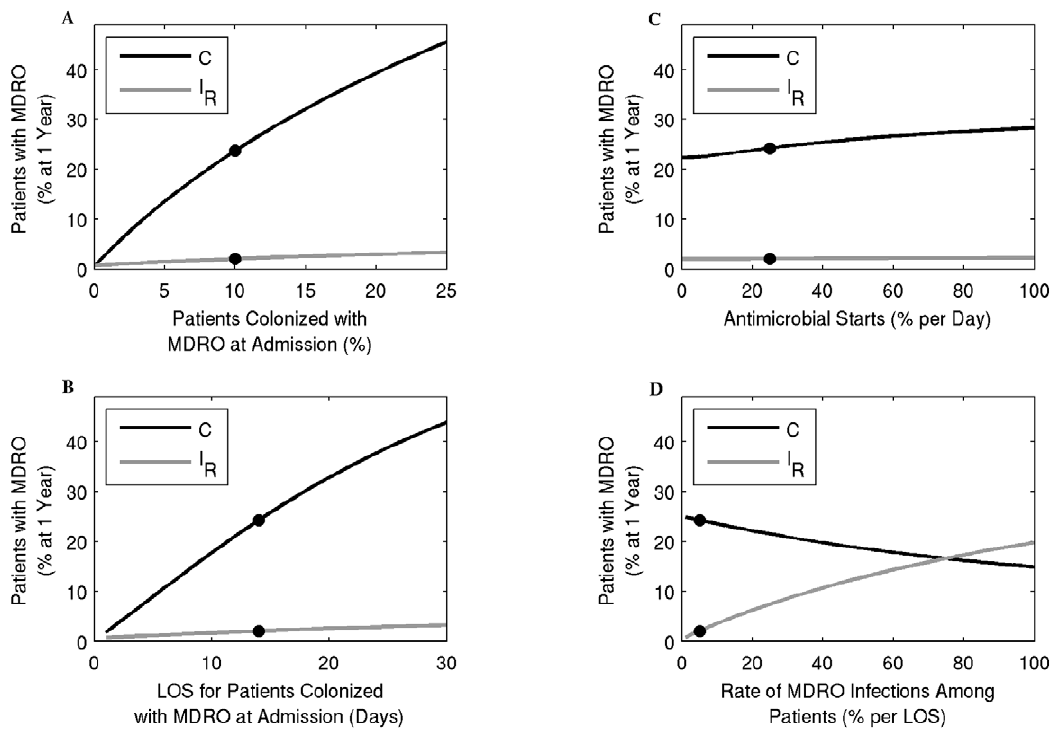
Figure 4. The percent of patients that are colonized with MDRO (black line) or infected with MDRO (grey line) at one year. (A) - the percentage of patients colonized with MDRO at admission is varied; (B) - the length of stay (LOS) of patients colonized with MDRO is varied; (C) - the percent of MDRO-colonized patients becoming infected during their stay in the hospital is varied; and (D) - the percent of MDRO-colonized patients starting antimicrobials per day. The dots mark the baseline